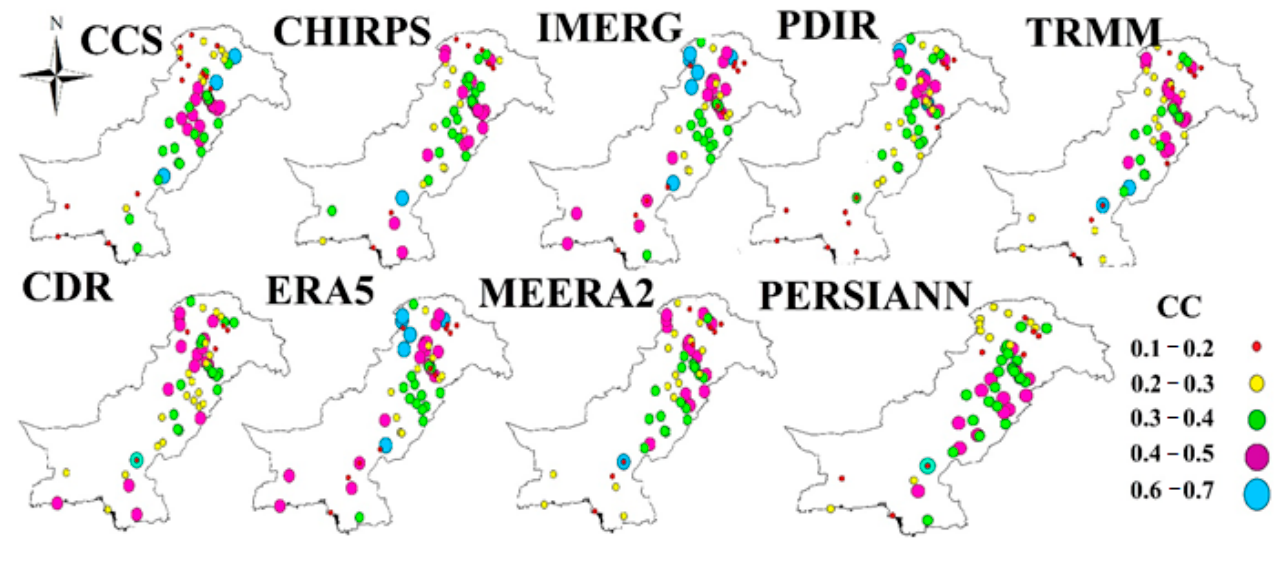
Figure 11. Influence of the precipitation intensity on daily time scale evaluation indices.